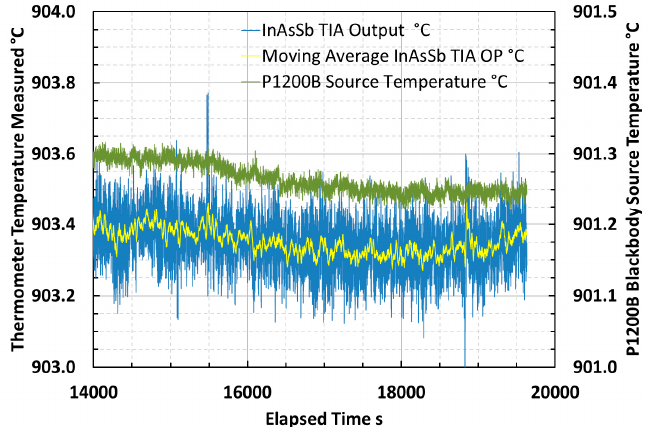
Figure 7. Noise in sampled thermometer signal and continuously-averaged mean thermometer signal, measuring steady-state source temperature of 900 °C.